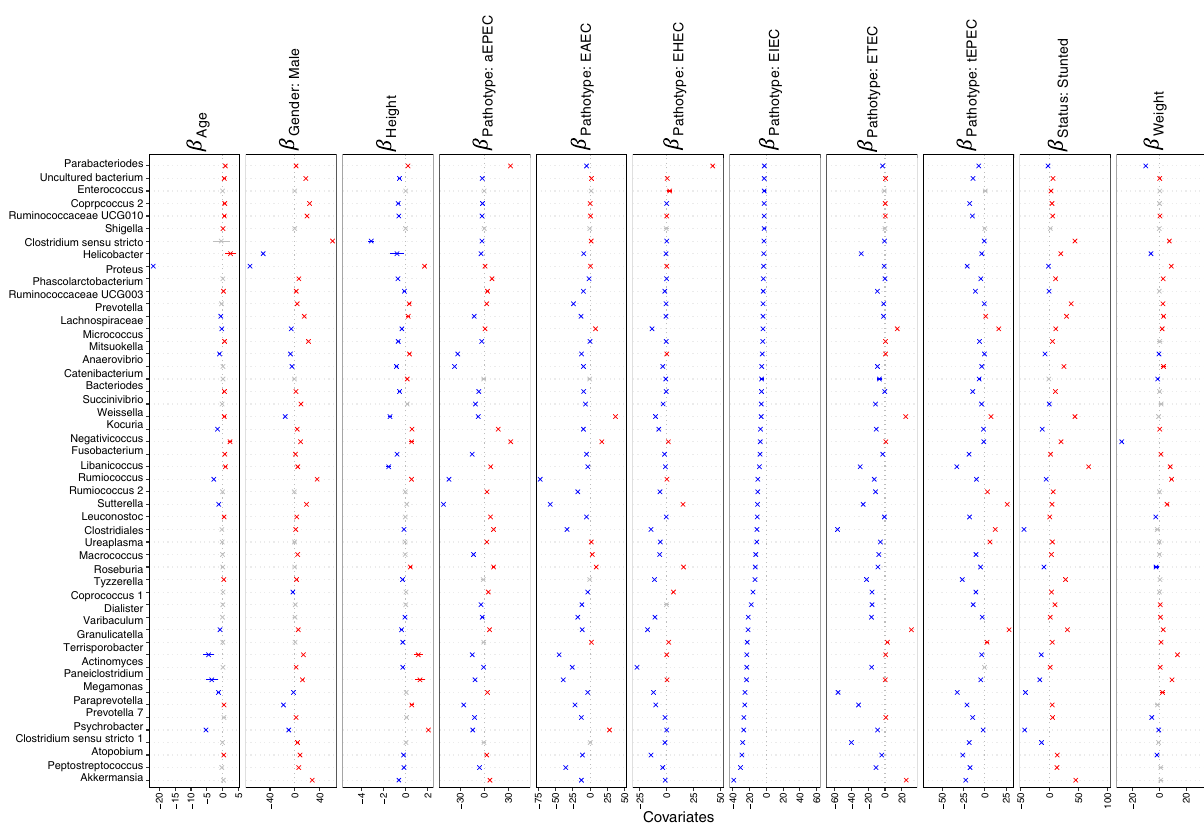
Figure 7. Continuation of Fig. 6 for the remaining beta-coefficients for 52 genera returned from the GLLVM procedure when considering pathotypes in the